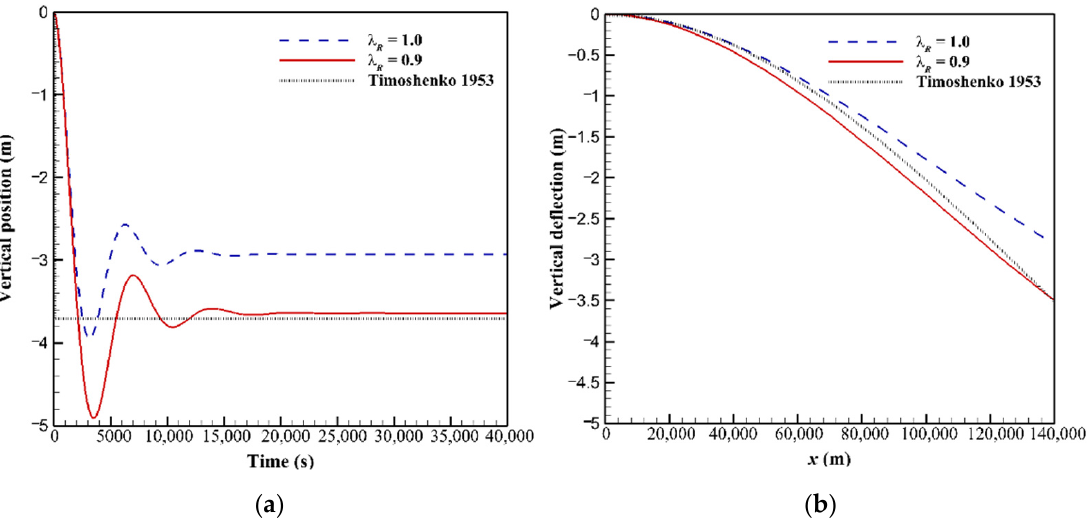
Figure 4. Simulation results for cantilever beam: ( a ) vertical variation of cantilever beam end; ( b ) vertical deflection of cantilever beam end.